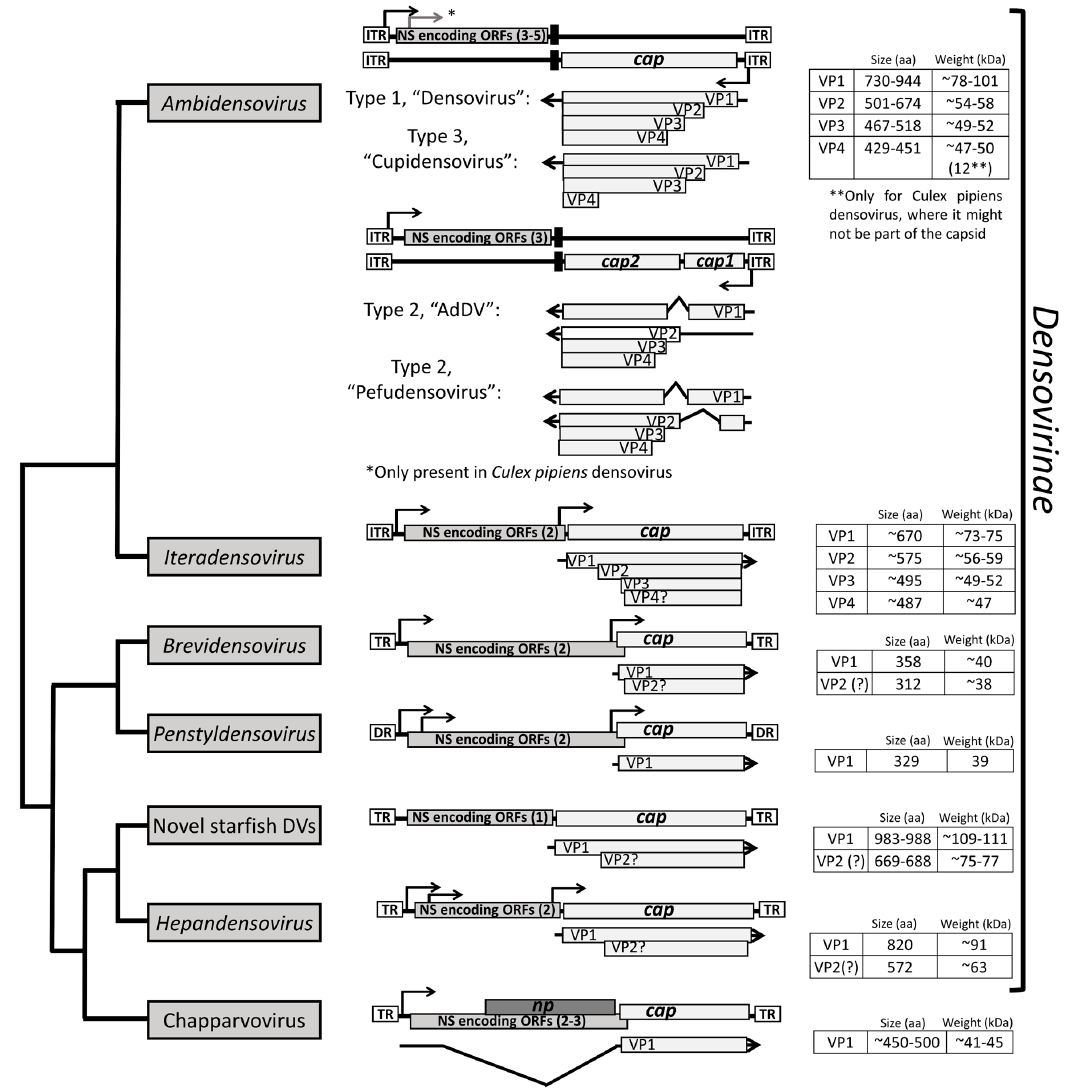
Figure 3. Cladogram of denso- and chapparvoviruses. The general genome organization and capsid protein expression strategy are shown. The ns genes are simplified and only the ORF is shown. The transcription strategy of members of genus Hepandensovirus , as well as of the new, unclassified starfish densoviruses, have not been determined, thus the sizes of the VPs are based on in silico